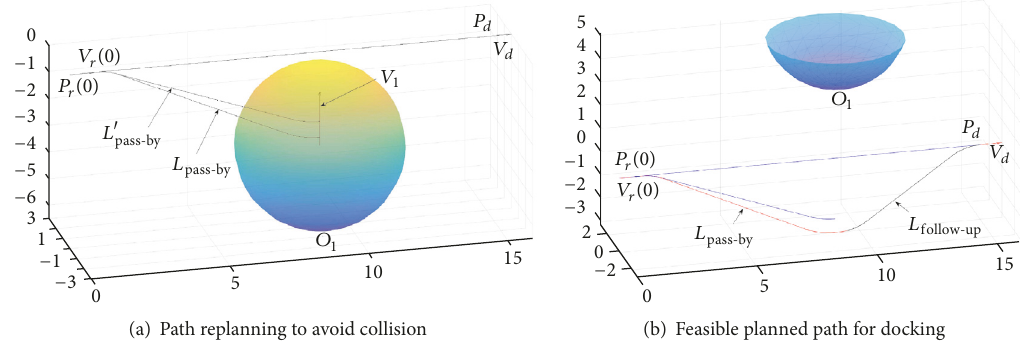
Figure 5: Example of the DAPF path planning strategy in environment with one obstacle. (a) The intermediate configuration is determined as well as 𝐿 pass . (b) The planned path is collision-free and feasible for docking. - by